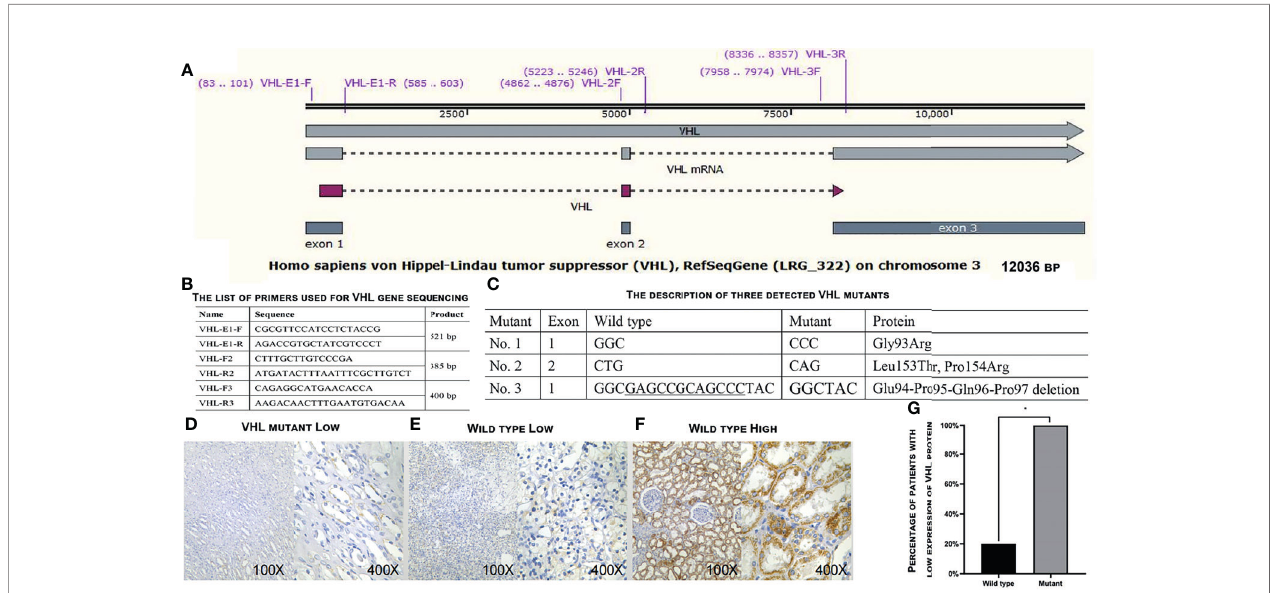
FIGURE 4 | Determination of VHL gene expression in the 21 patients. (A) A diagram showing the structure of VHL gene and positions of primers used for gene sequencing. (B) The list of primers used to sequence VHL gene. (C) The description of three detected VHL mutants. (D – F) Representative images showing the low expression levels of VHL protein in patients carrying mutant VHL (D) or wild-type VHL (E) and high expression levels of VHL protein in patients carrying wild-type VHL as detected by immunohistochemical staining in ccRCC patients enrolled in our hospital. (G) A plot showing the percentage of patients with low expression levels of VHL protein in patients carrying wild-type or mutant VHL gene. VHL, Von Hippel – Lindau; ccRCC, clear cell renal cell carcinoma. *p < 0.05.